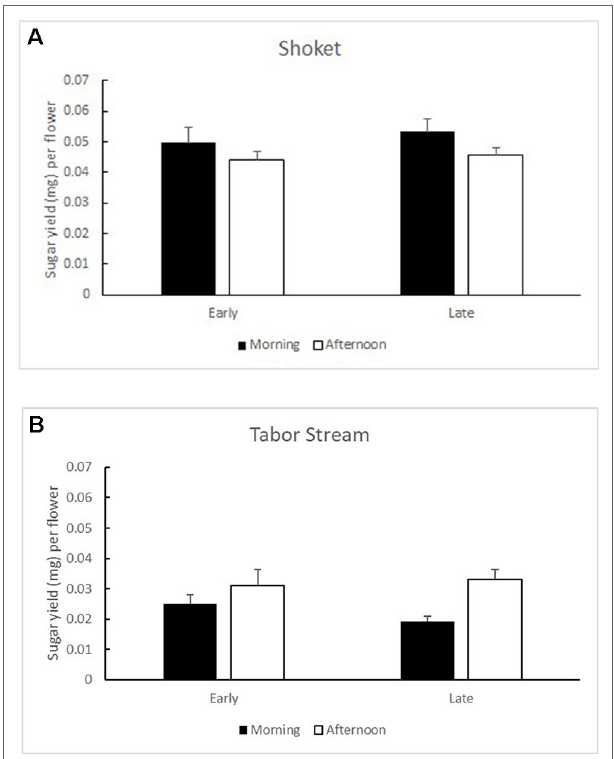
FIGURES 4 | Mean (+ SE) sugar yield per flower in Early (left) and Late (right) trees, sampled in the morning (black bars) and in the afternoon (white bars) in the two study populations: (A) Shoket and (B) Tabor Stream.